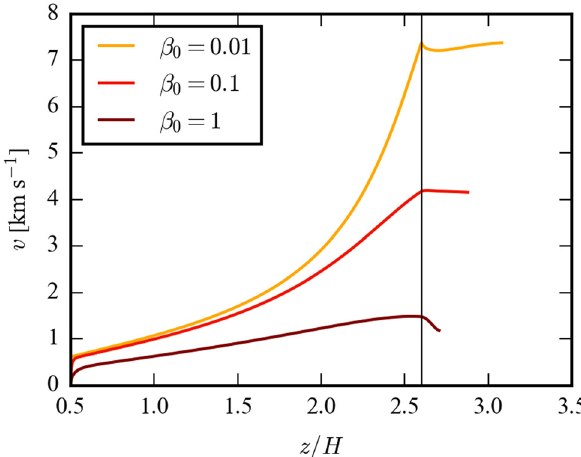
H 0.4 0 = Figure 3: Dependence of the MFT ’ s speed on the z - coordinate for various initial plasma beta β in runs without external magnetic 0 fi eld. Vertical line delineates the surface of the disk. Initial para - meters: r 0.5 au = , z H 0.5 0 = , and a H 0.1 0 =